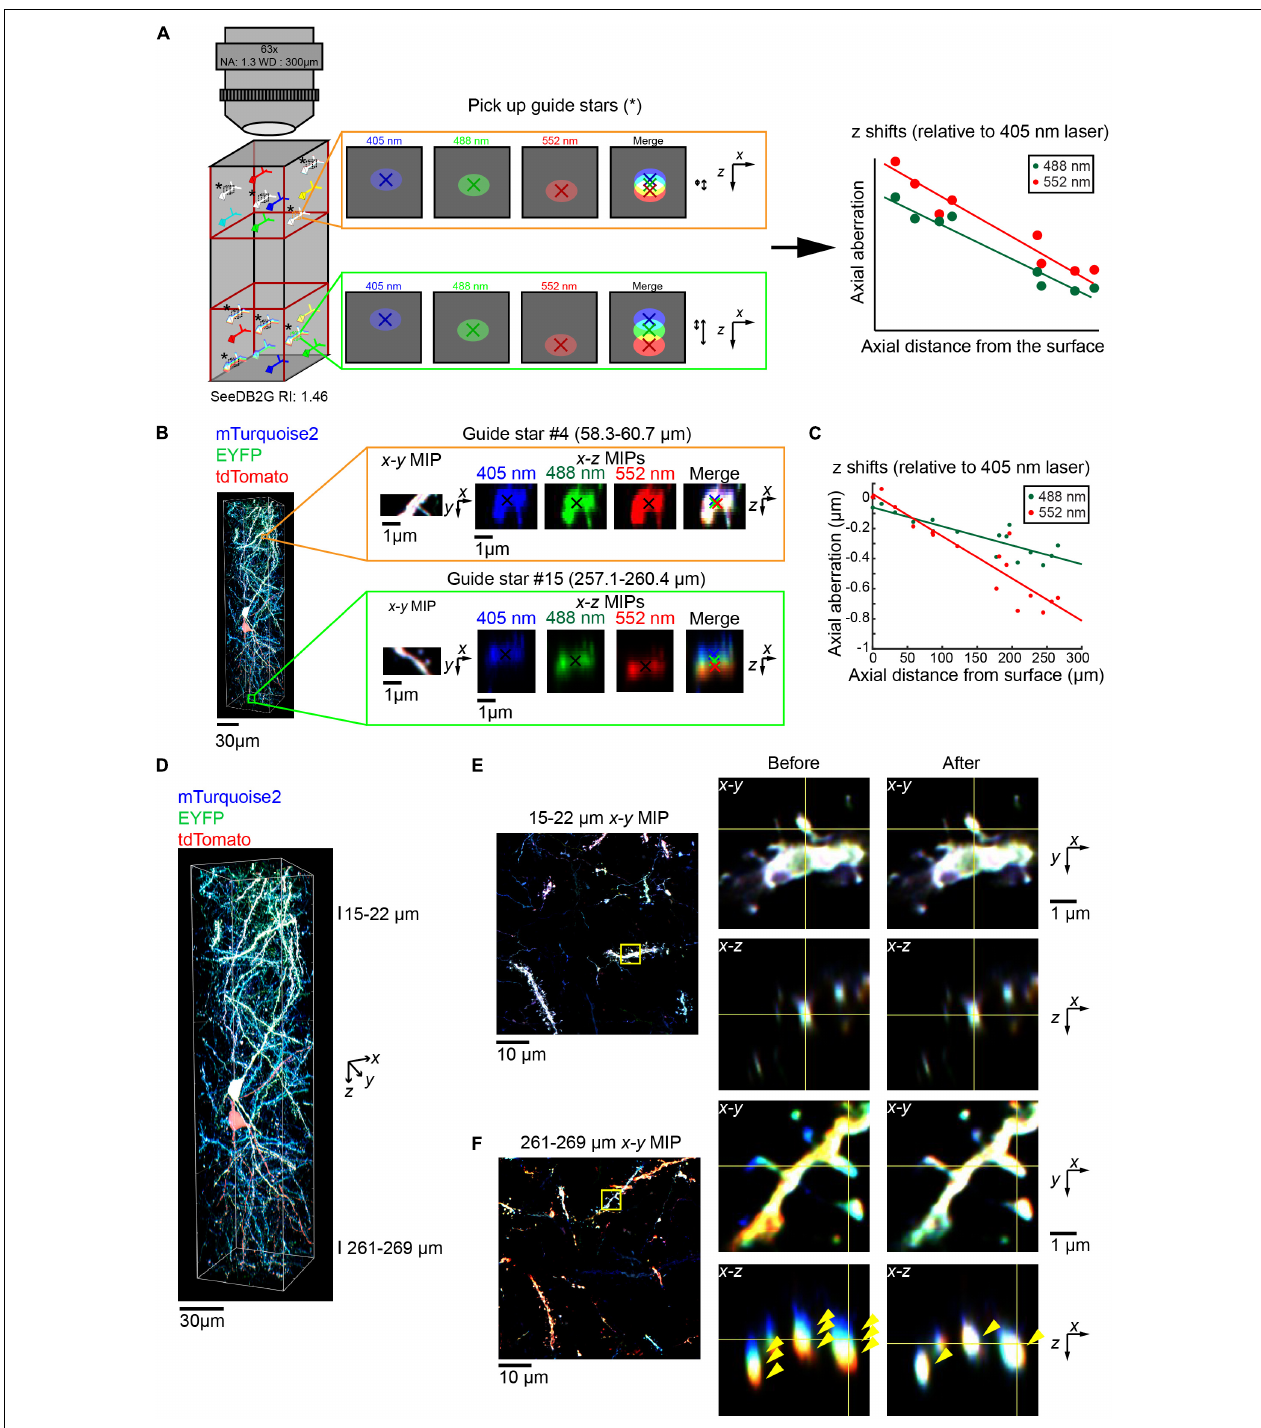
FIGURE 6 | Correction of volumetric fluorescence images of the brain based on “guide star” measurement. (A) Schematic for the chromatic aberration correction using guide stars. Instead of beads, we can use guide stars within a biological sample to record the chromatic aberrations. Guide stars should be isolated from other objects along x, y, and z and labeled with all the fluorophores. As the regression is linear, guide stars were taken from the top and bottom third (left cartoon). The axial chromatic aberration of each guide star was then calculated using the differences in the center of mass for each channel (middle cartons). These aberrations were then used to calculate the linear regression (right cartoon). (B) A 63 × glycerol lens was used to image a volumetric fluorescent image of a 300 µ m thick coronal section containing layer 2/3 cortical pyramidal neurons labeled with Tetbow plasmids at E15, age P101. Two (out of 16) representative guide stars, showing